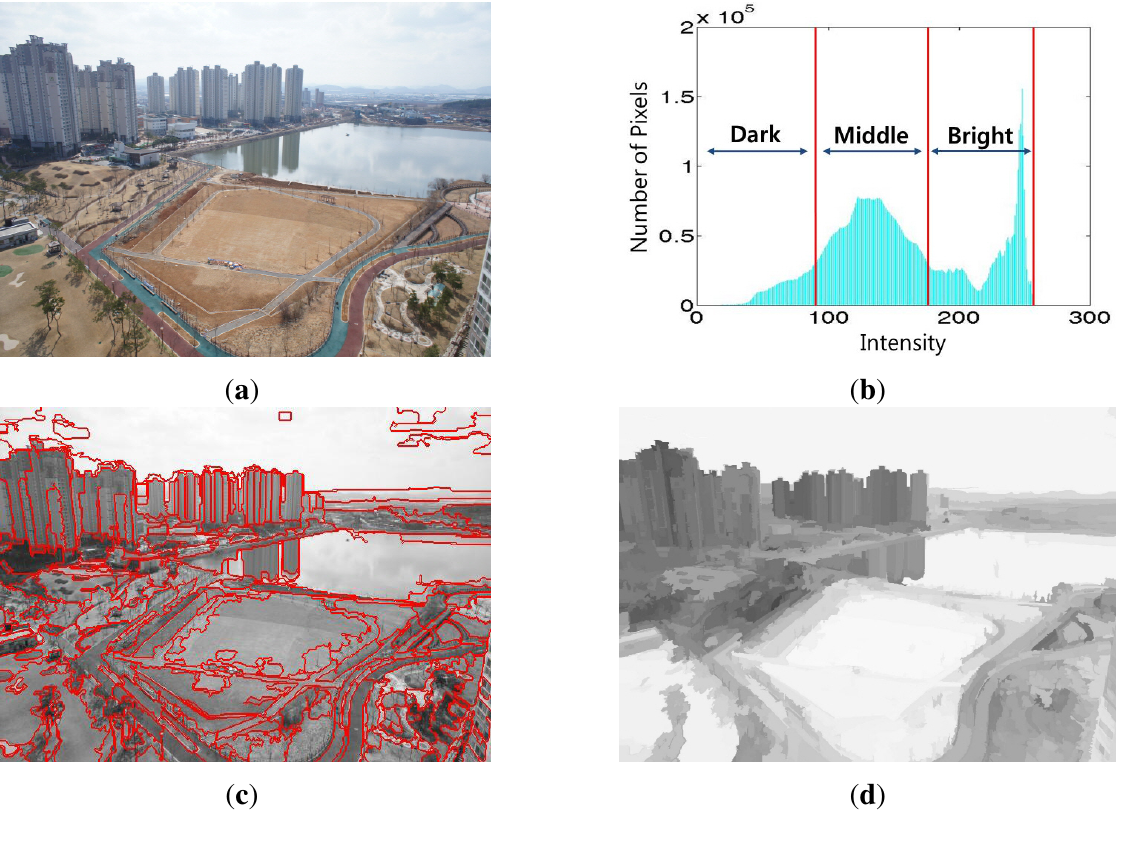
Figure 7. ( a ) A hazy aerial image; ( b ) the corresponding histogram classified into the dark, middle and bright ranges; ( c ) the result of histogram merging-based segmentation; and ( d ) the result of